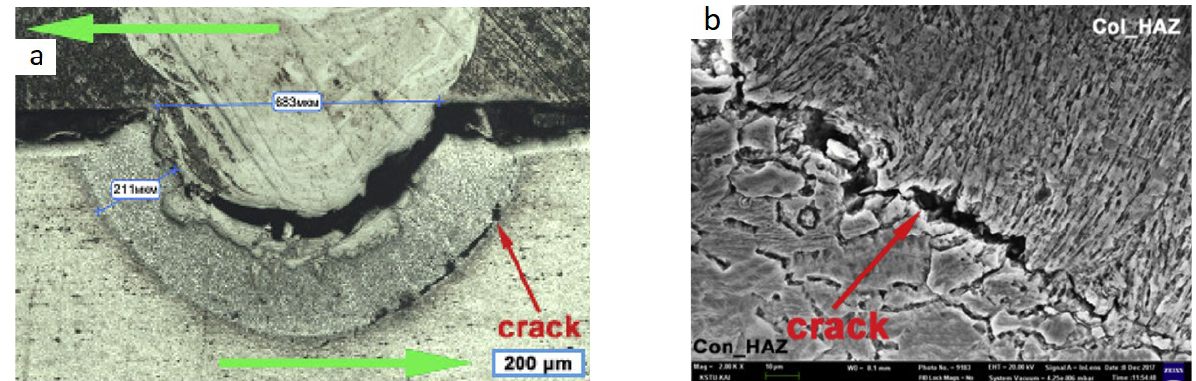
Figure 17. Microstructure of the Ti–Al after TSS (tensile shear strength): ( a ) welded joint microstruc- ture (green arrows is a TSS direction), ( b ) crack microstructure [20].